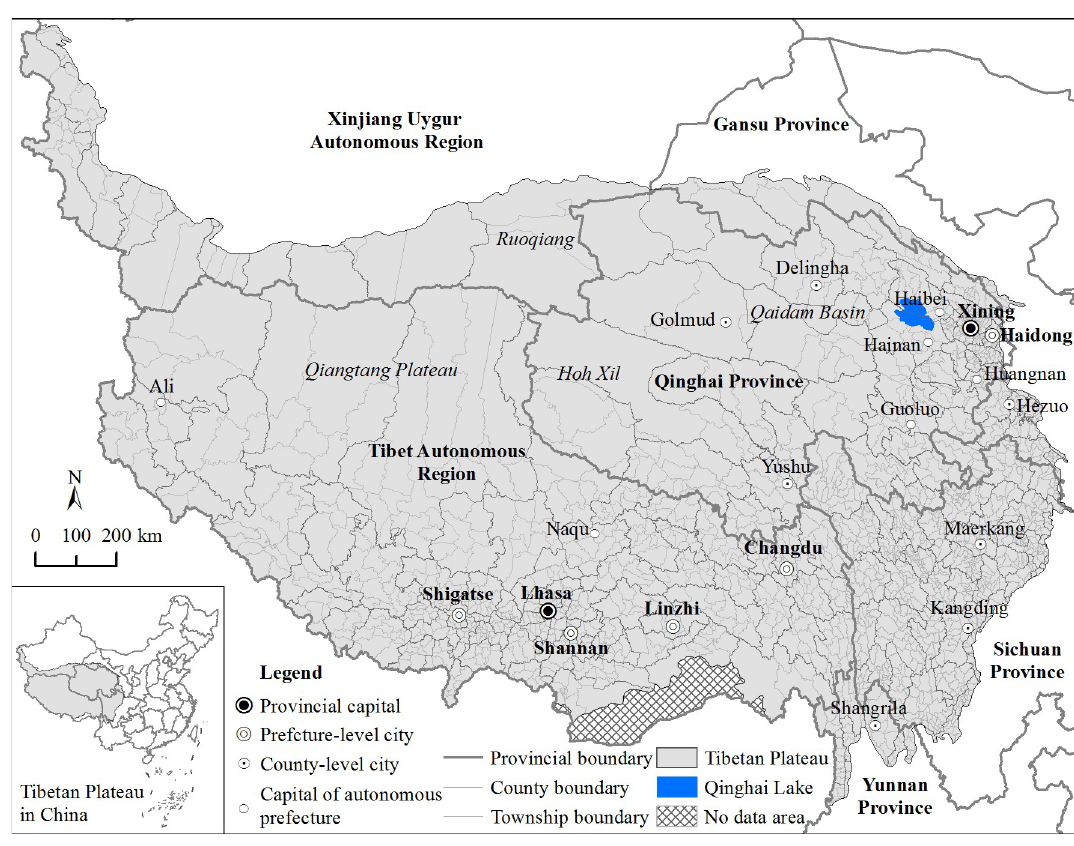
Fig 1. Location of the Tibetan